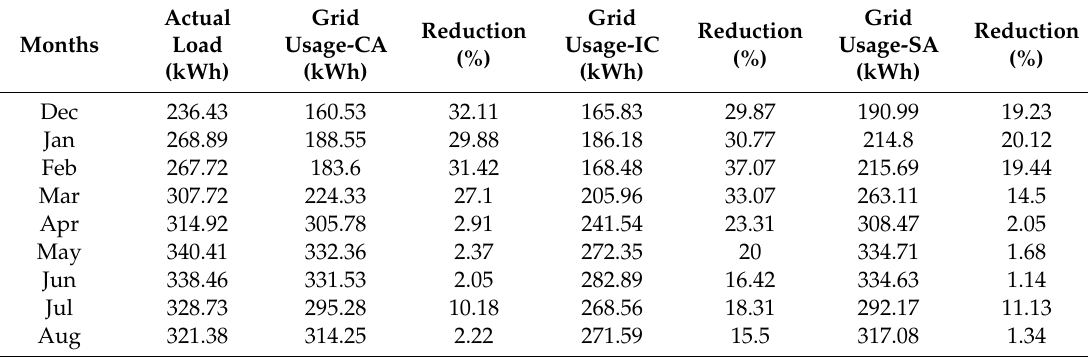
Table A5. Monthly grid usage reduction for CP load using three strategies at SHAC.